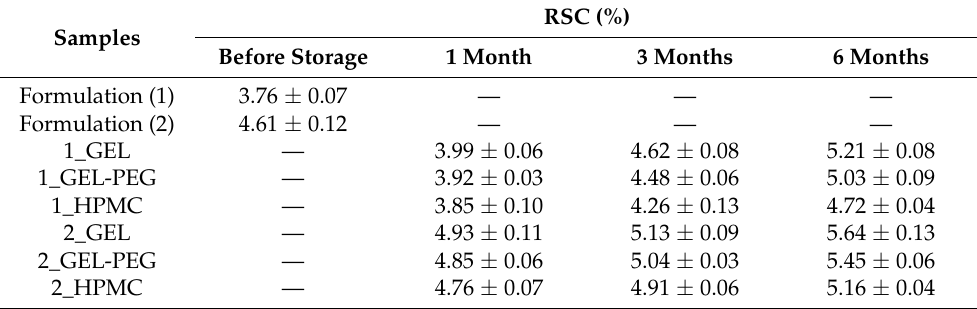
Table 4. RSC values of DPI powders during the stability test.